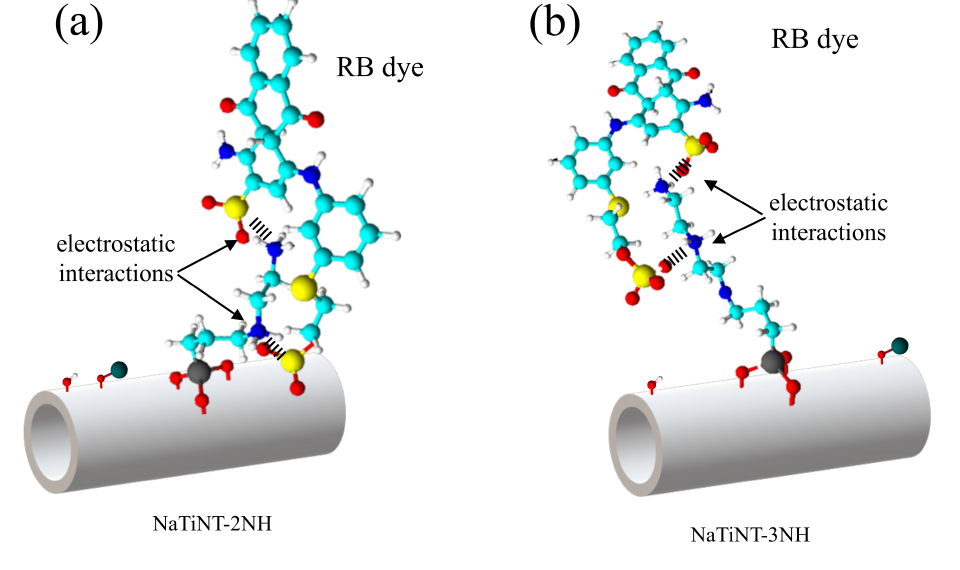
Figure 8. Scheme of the adsorption process of RB on ( a ) NaTiNT − 2NH and ( b ) NaTiNT −